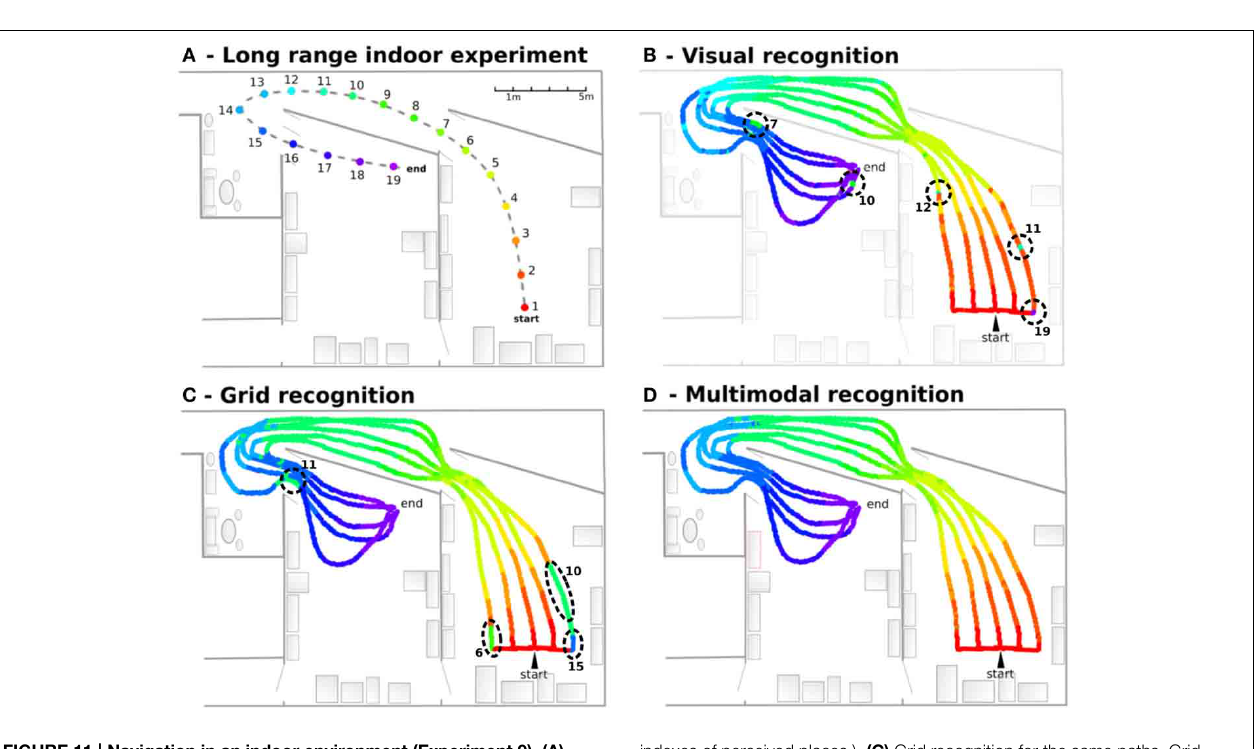
indexes of perceived places.). (C) Grid recognition for the same paths. Grid fields are smaller but without any ambiguities. A place is not recognized if the robot is too far away from the learned place. (D) Multimodal recognition obtained by merging visual and grid place cells. The synergy of both modalities shows well-defined areas even if the robot is far from the learned